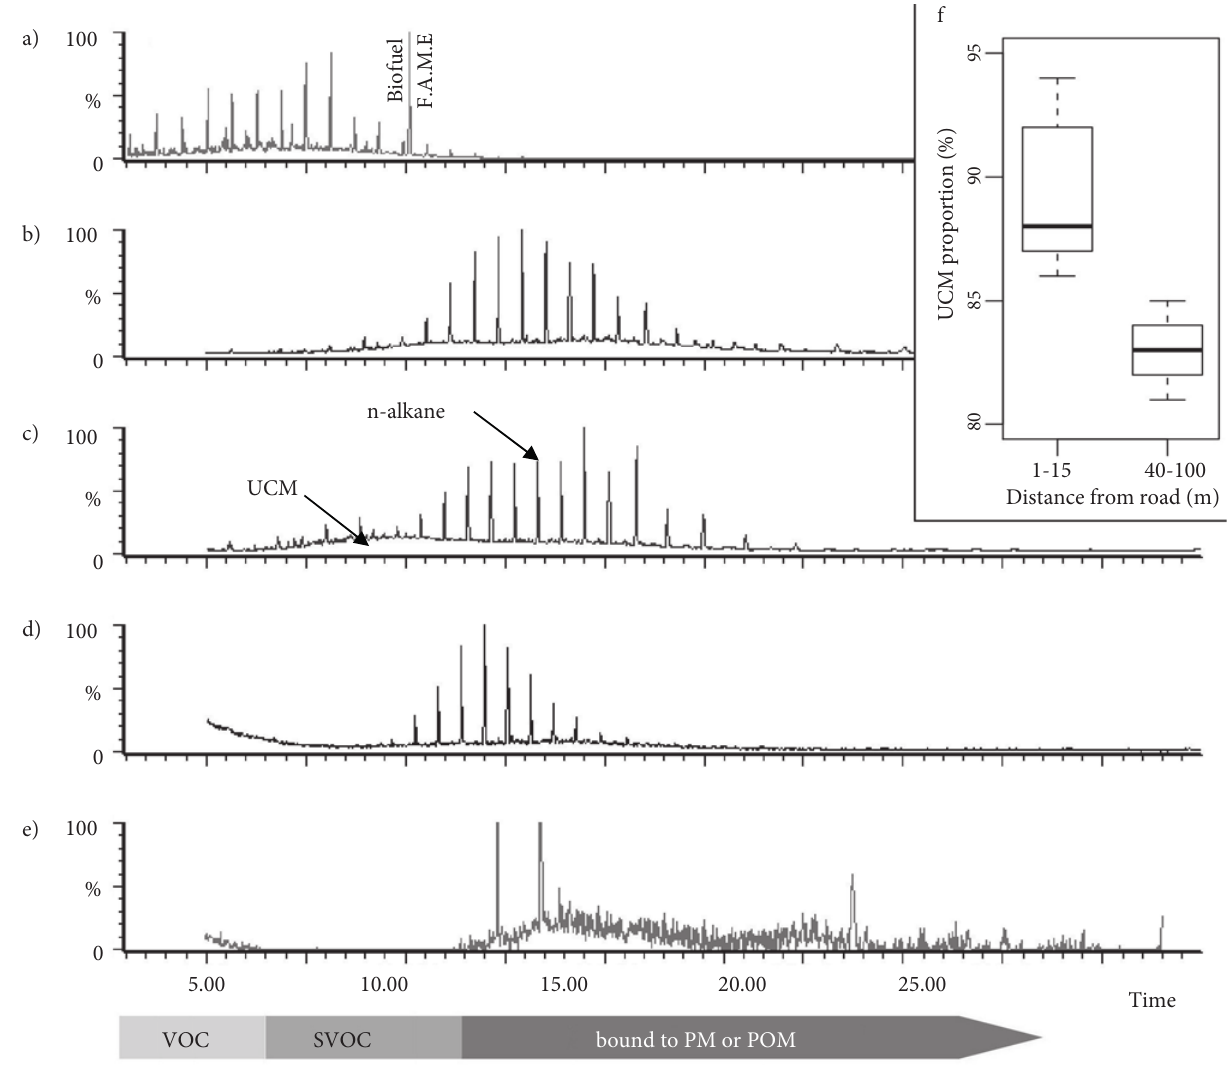
Fig. 7. GC-MS chromatograms of: (a) commercial diesel fuel, containing 5% fatty acid methyl esters (F.A.M.E.), purified hexane extract of roadside soils, distance; (b) 1 m ; (c) 40 m; and (d) 100 m from Pushkinskaya street; (e) purified hexane filter extract; (f) boxplot of the percentage of unresolved complex mixture (UCM) compounds from total, distance classes 1–15 and 40–100 m, sam- pling depth 0–0.5